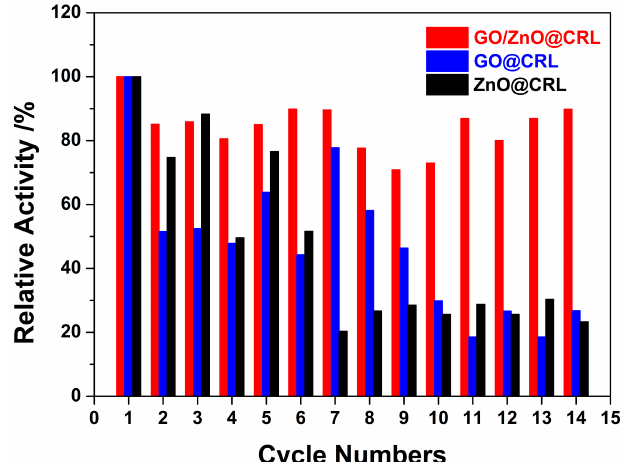
Figure 6. Reusability of the immobilized lipase. Reaction conditions: 30 mg GO/ZnO@CRL, 1 mL 0.5% p -NPP ethanol solution ( w : v ), 1 mL 0.1 M pH 7.0 phosphate buffer, 37 °C, 30 min. The biocatalyst